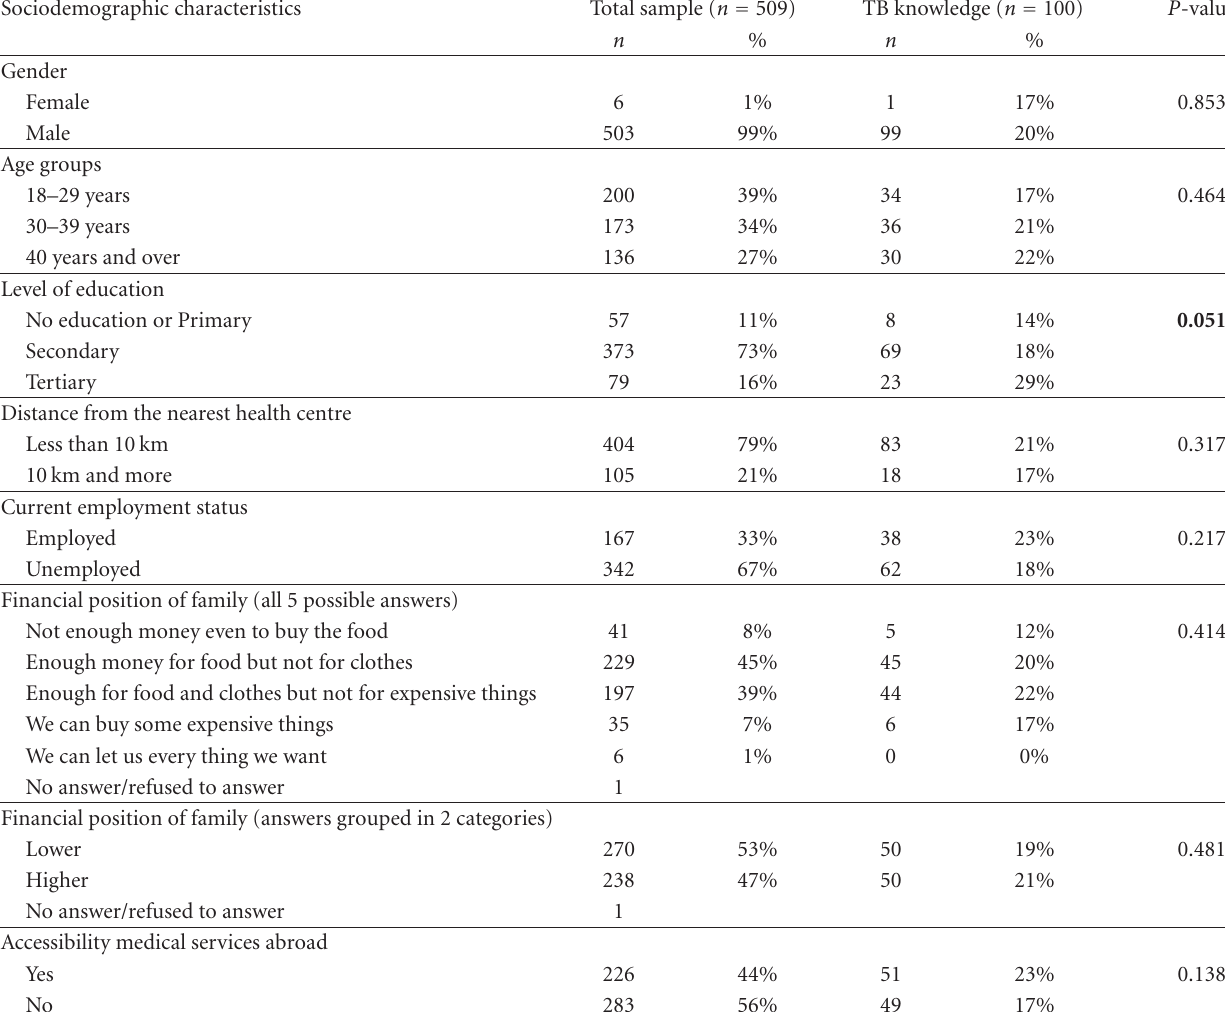
Table 2: Su ffi cient ∗ TB knowledge associated with main sociodemographic characteristics of migrants. Sociodemographic